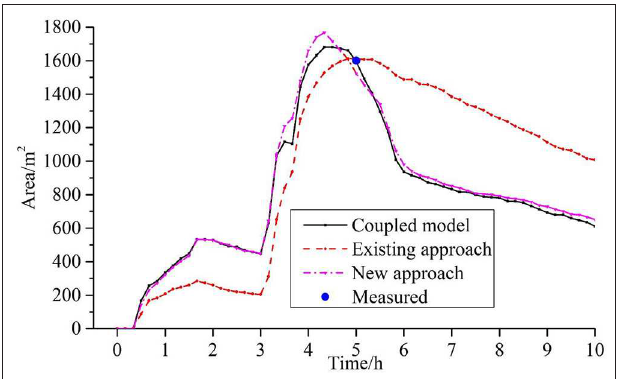
FIGURE 11 | Simulation results of the areal inundation evolution under different approaches.